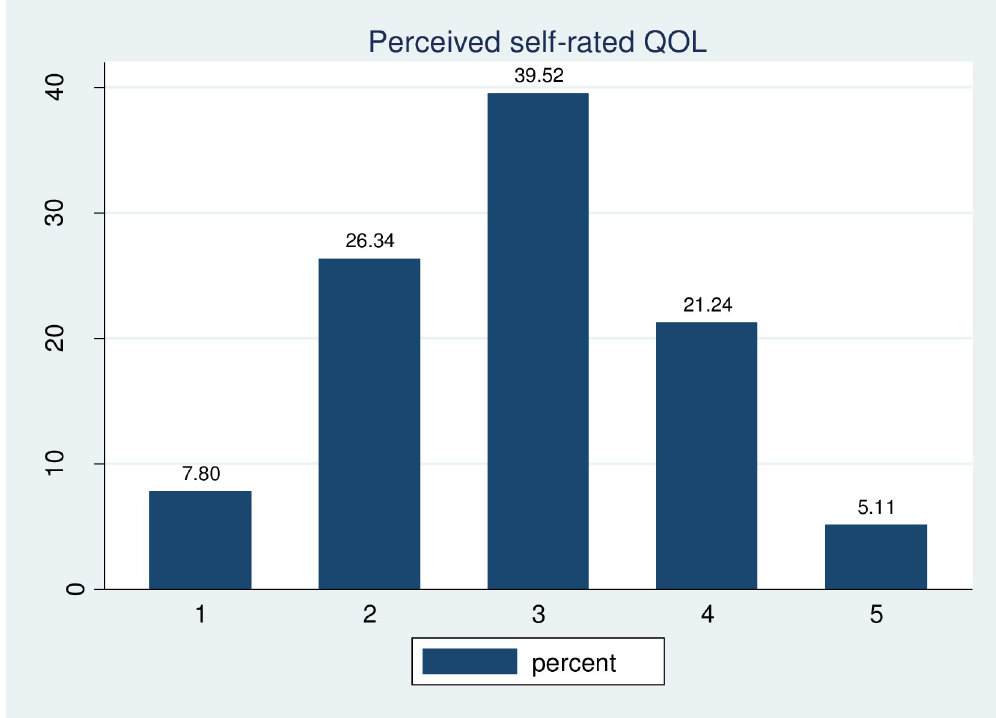
Fig 2. Perceived self-rated QOL of substance youths in central Gondar zone,